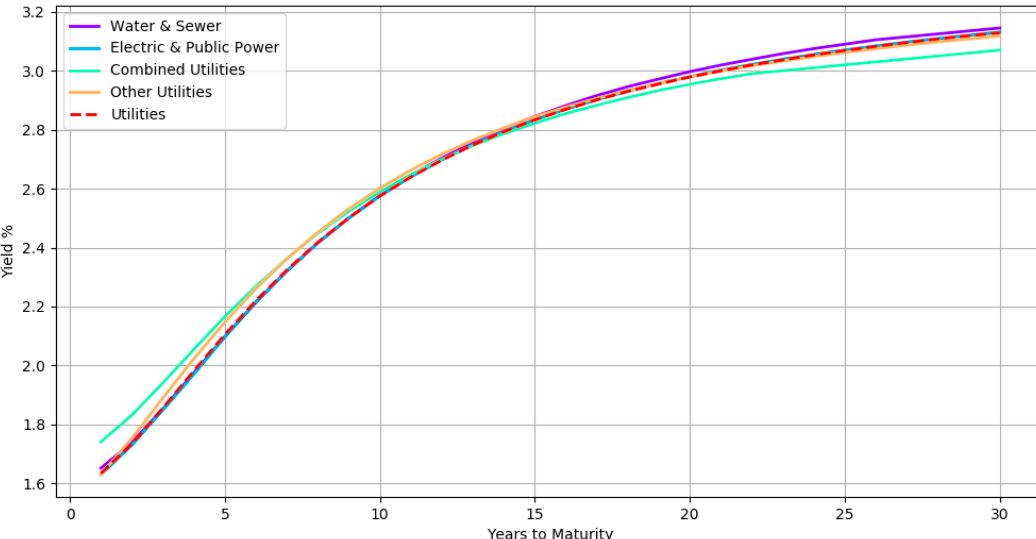
Figure 7. Visualizing the latent hierarchical relationship. The red dashed line is the yield curve of a sector. The rest of the solid lines correspond to its children subsectors.